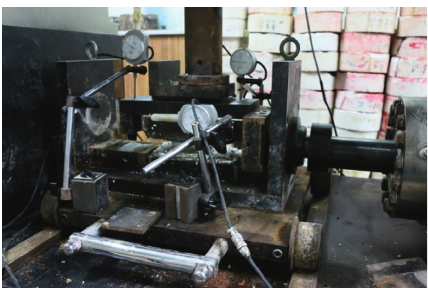
Figure 6: Displacement sensor installation photo.